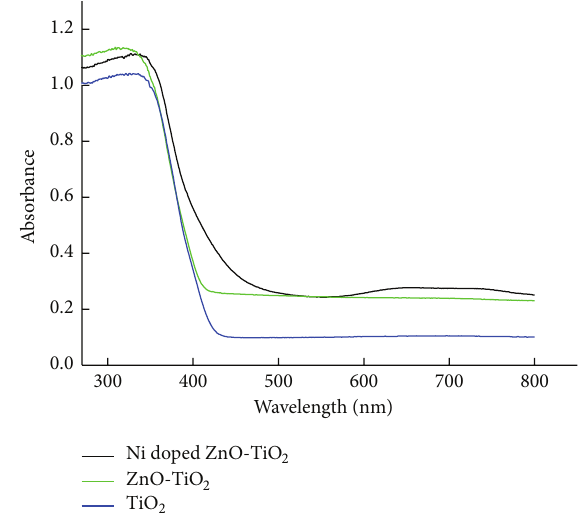
Figure 2: DRS spectra of TiO 2 , ZnO-TiO 2 , and Ni doped ZnO-TiO 2